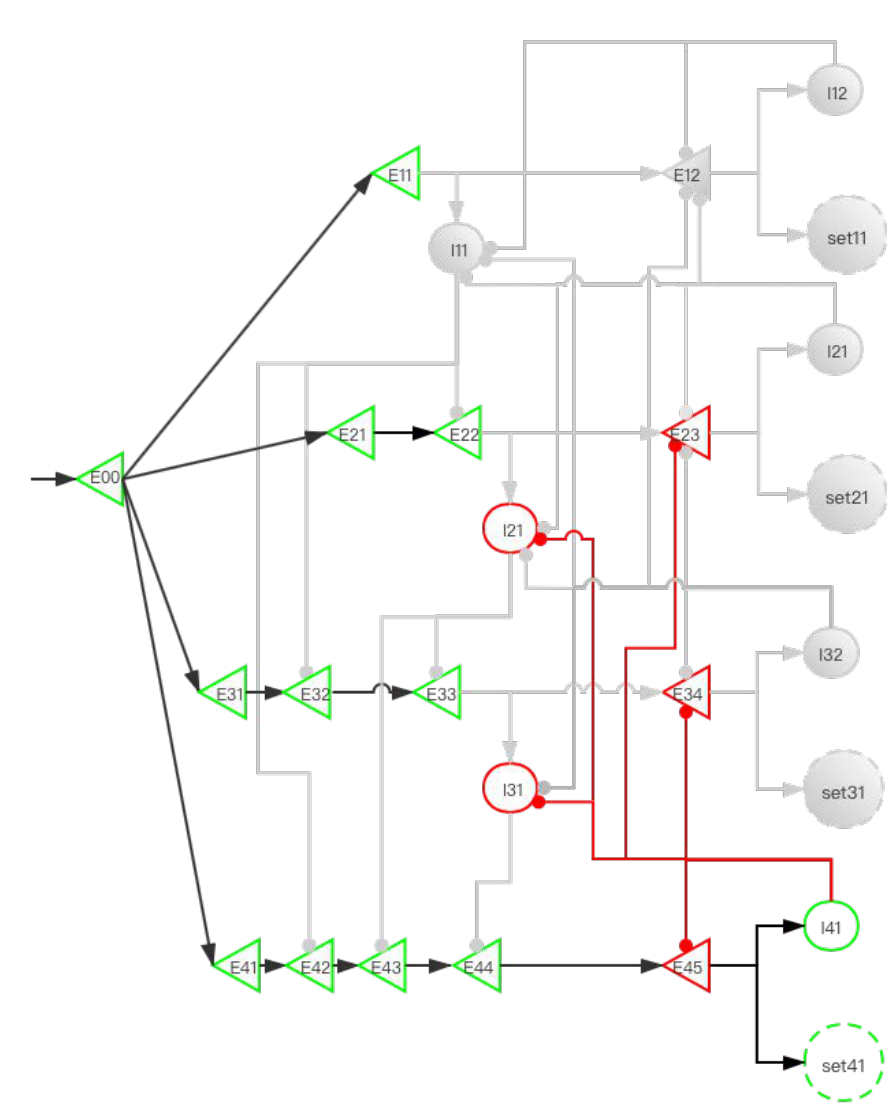
Figure 11. The activity of neurons in the time period from the activation of set41 by the fourth signal to the activation of E11 by the fifth signal (before E12 is activated). After the fourth signal enters, when E45 is activated, I41 inhibits I21, I31, E23, E34, and E45. All neurons in the E11 unit are not inhibited at this time. When the fifth signal is reached, repeat (Figure